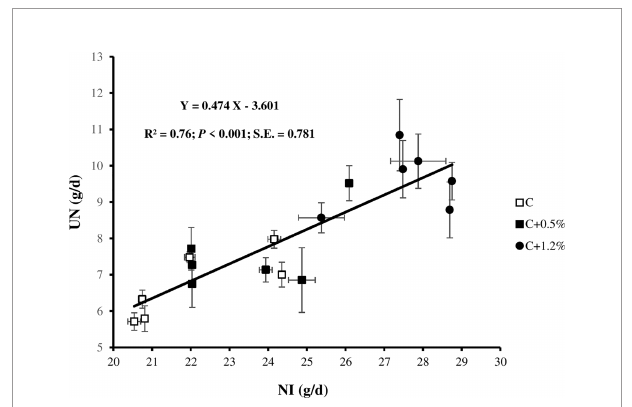
FIGURE 1 | Relationship between urinary nitrogen (UN) and N intake (NI) for individual observations of the sheep offered three different levels of non- protein N: C, control dietary treatment with maintenance NI allowance; C +0.5%, control dietary treatment with maintenance plus an additional 15% NI allowance; C+1.2%, control dietary treatment with maintenance plus an additional 33% NI allowance. The error bars show SE.